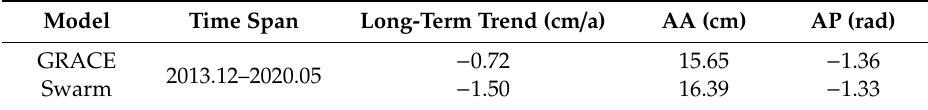
Figure 8. The terrestrial water storage change (TWSC) time series in the Amazon River basin calculated using GRACE (blue curve) and Swarm (green curve).